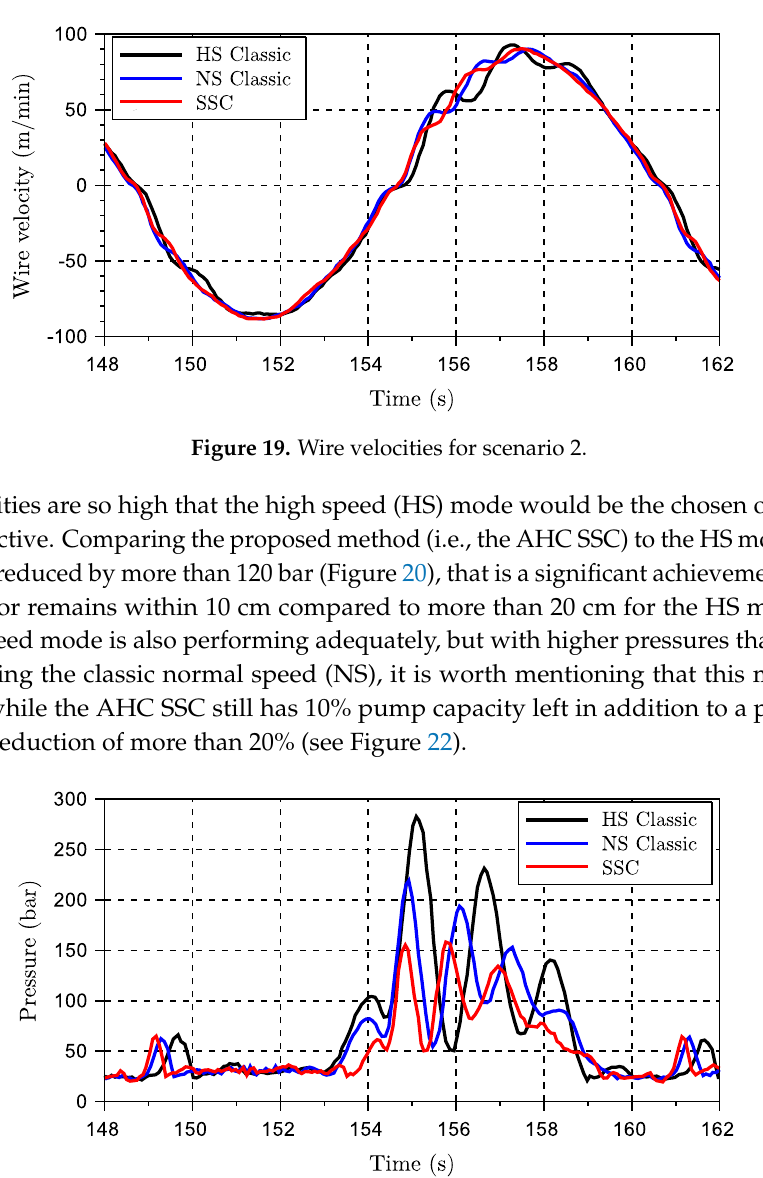
Figure 20. Pressure levels on the A-side of the active system for scenario 2.